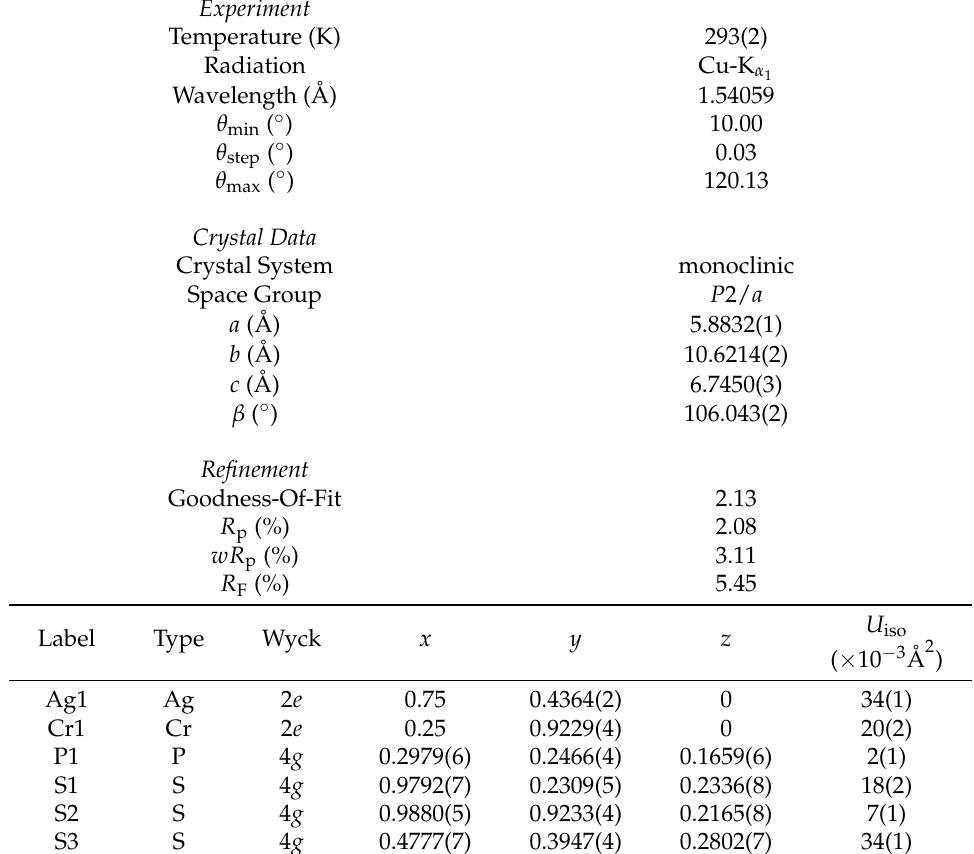
Table 2. Top : Summary of experimental parameters of the pXRD experiment on AgCrP 2 S 6 , extracted lattice parameters and reliability factors of the structural model obtained by the Rietveld method. Bottom: Refined crystal structure model of AgCrP 2 S 6 and isotropic displacement parameters with standard deviations given in parentheses. All sites were treated as fully